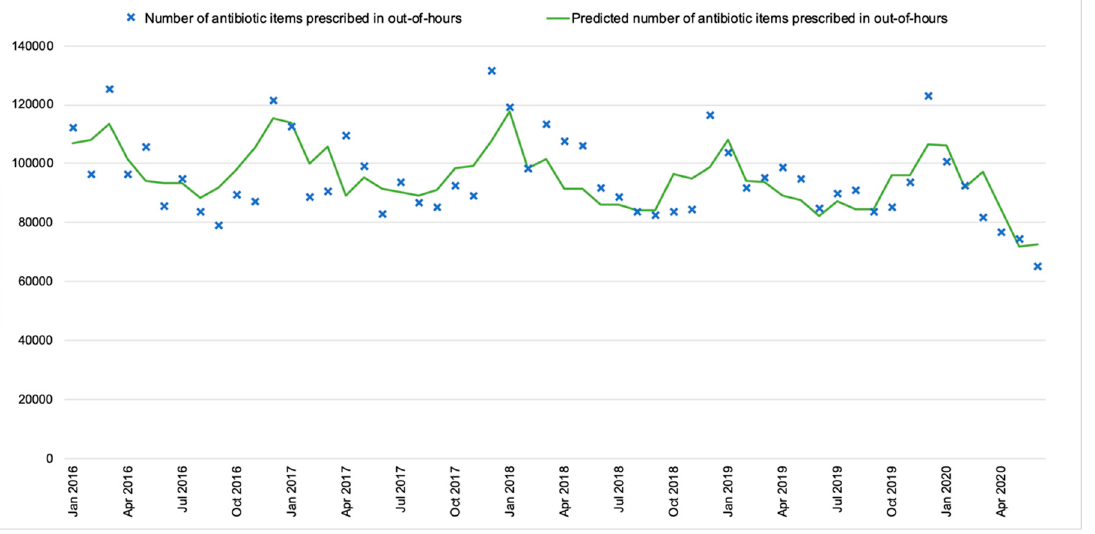
Figure 5. Out-of-hours antibiotic prescribing against the predicted trend (England, 2016–2020). Since March 2020, the proportion of broad-spectrum prescriptions rose in both set- tings. In IH, the downward trend of the proportion of broad-spectrum prescribing switched direction and started to rise from March, increasing by 0.7% per month (95% CI: 0.3% to 1.2%, P < 0.05). In OOHs, though the proportion of broad-spectrum antibiotic pre- scribing showed no significant overall change prior to March 2020, it started increasing by 1.4% per month (95% CI: 0.9% to 1.9%, P < 0.05) since. 3. Discussion The introduction of national antimicrobial stewardship initiatives has reduced anti- biotic prescribing primary care in England. Despite the overall decline in primary care antibiotic prescribing between January 2016 to February 2020, the prescribing volume in OOH remained unchanged. The prescribing of broad-spectrum antibiotics in OOH has been consistently higher than IH, as previously reported using data between 2010 and 2014 from 143 out of 221 Clinical Commissioning Groups (CCGs) in England [12]. The positive impact of the QP that was aimed at increasing the use of nitrofurantoin as the first-line treatment for uncomplicated UTI is evident [23], with a decrease of the trime- thoprim-to-nitrofurantoin ratio across primary care including OOH settings, though data for assessing QP in OOH is incomplete. The COVID-19 pandemic and the national re- sponse have led to a reduction in prescribing in both IH and OOH GPs since March 2020, which may tell us more about patient health-seeking behaviour than clinician prescribing behaviours. The proportion of broad-spectrum antibiotics from the total prescribed anti- biotics has, however, increased in both IH and OOH GPs. Co-amoxiclav and doxycycline use in OOH peaked between March and May 2020, probably due to the uptake and im- plementation of National Institute for Health and Care Excellence (NICE) prescribing guidelines advising doxycycline for the management of community-acquired pneumonia when the cause was unclear during the COVID-19 pandemic [24]. As a percentage of the total, co-amoxiclav may have increased, as OOH clinicians prescribed broad-spectrum an- tibiotics more frequently to cover a greater range of potential infections when they were unable to assess their patients face to face. We cannot rule out a changing epidemiological profile of infectious diseases due to COVID-19 as a possible factor in the decline in OOH antibiotic prescribing, resulting from control measures and a consequent reduced transmission of other respiratory tract infec- tions. Indeed, PHE’s OOH GP syndromic surveillance data indicates that although on av- erage 23% of all OOH GP contacts in England between 2009 and 2019 were due to acute respiratory infection [25], OOH GP contacts for acute respiratory infections, including